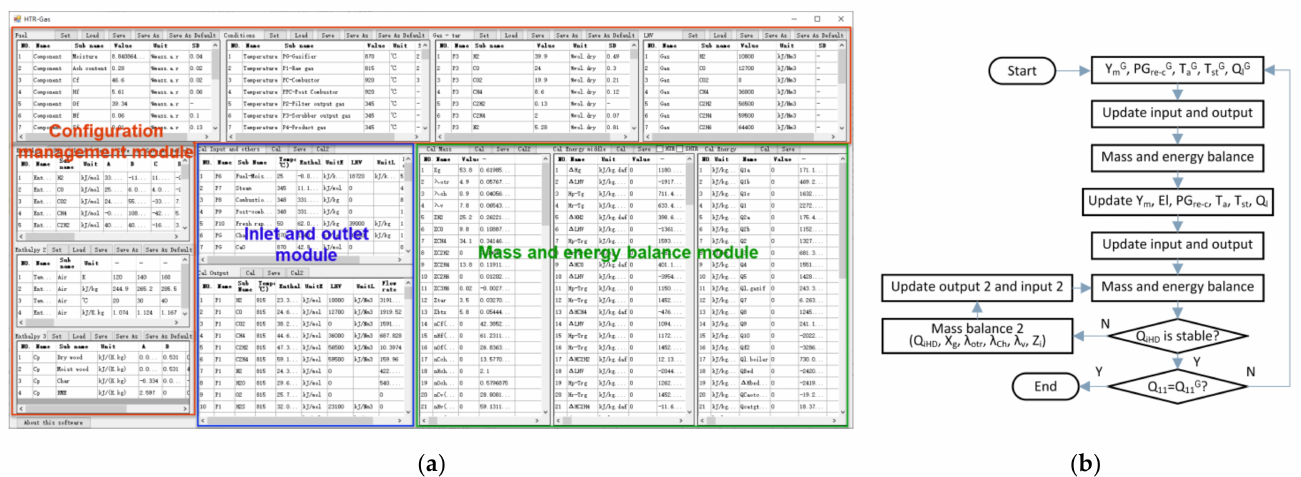
Figure 4. Software for calculating mass and energy balances of biomass gasification. ( a ) Main interface of software; ( b ) flow chart of software for calculating mass and energy balances. ( Y m : moisture to dry ash-free fuel ratio; PG re − c : recirculation fraction of product gas; T a : temperature of inlet air of combustor; T st : temperature of inlet steam of gasifier; Q 1 : heat losses of DFB; El : introduced auxiliary electricity for heating biomass; Q iHD : internal heat demand of gasifier; Q 11 : heat extracted of combustor; X g : fraction of char gasified; λ Otr : transported oxygen to fuel equivalence ratio; λ ch : fraction of char gasified and then combusted; λ v : fraction of volatiles combusted; Z i : fraction of volatiles converted to raw gas compound i (H 2 , CO, CH 4 , C 2 H 2 , C 2 H 4 , C 2 H 6, tar, BTX (benzene, toluene and xylene), etc.); G : related parameters under experimental conditions of GoBiGas